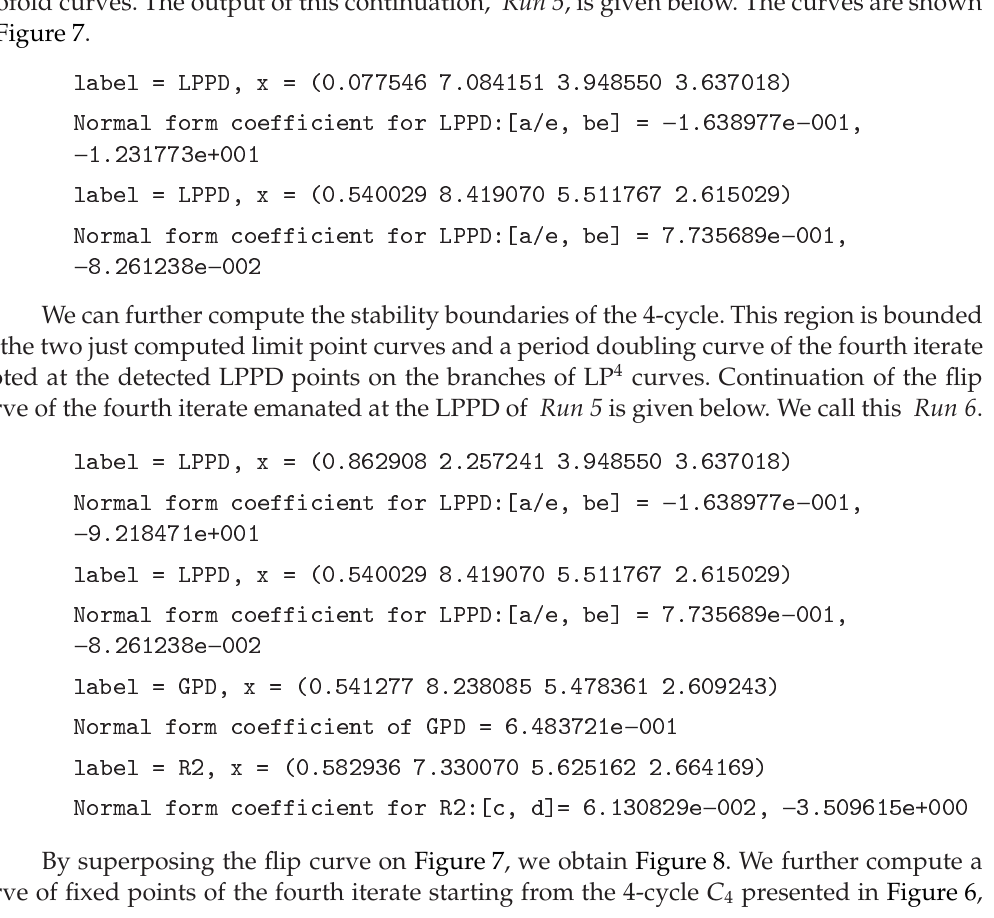
twofold curves. The output of this continuation, Run 5 , is given below. The curves are shown in Figure